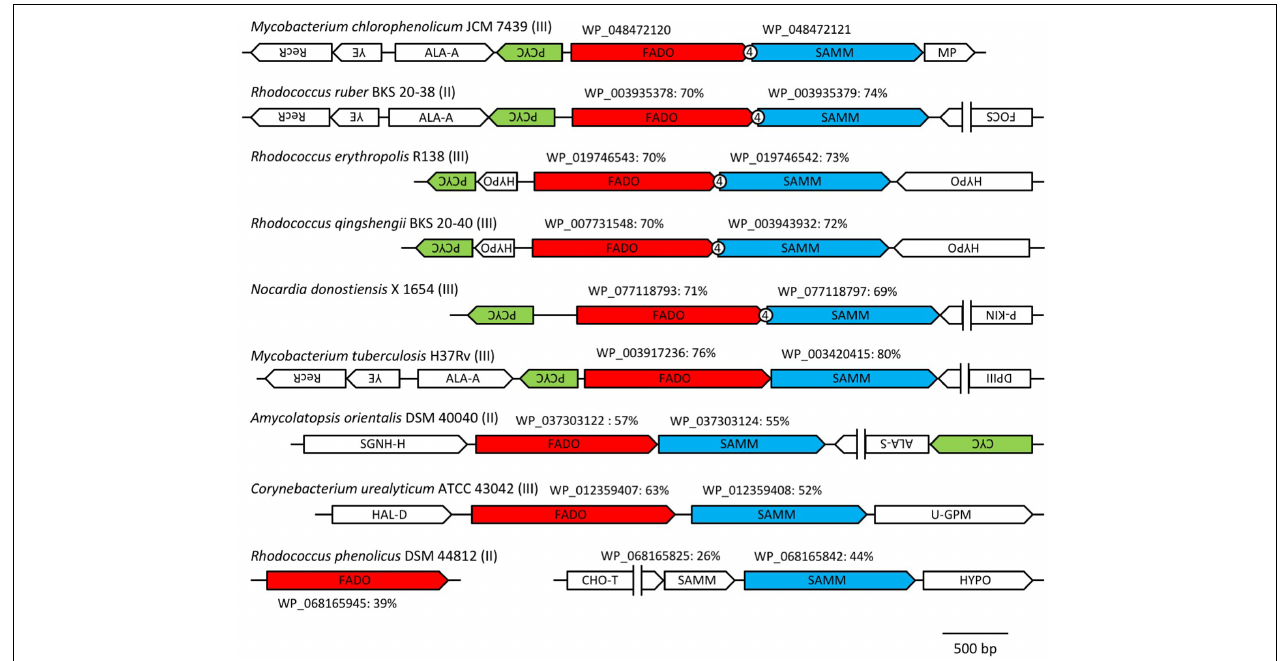
FIGURE 2 | Arrangements of the orthologous genes of the FAD-binding oxidoreductase WP_048472120 and SAM-dependent methyltransferase WP_048472121 among microorganisms that produce medium branched-chain fatty acids (mBFAs). The orthologous genes of the FAD-binding oxidoreductase WP_048472120 and the SAM-dependent methyltransferase WP_048472121 were identified from the genomic sequences of Mycobacterium chlorophenolicum JCM 7439 (NZ_BCQY01000005), Rhodococcus ruber BKS 20-38 (NZ_AOEX01000025), Rhodococcus erythropolis R138 (NZ_CP007255), Rhodococcus qingshengii BKS 20-40 (NZ_AODN01000039), Nocardia donostiensis X 1654 (NZ_MUKP01000048), Mycobacterium tuberculosis H37Rv (NC_018143), Amycolatopsis orientalis DSM 40040 (NZ_ASJB01000001), Corynebacterium urealyticum ATCC 43042 (NC_010545), and Rhodococcus phenolicus DSM 44812 (NZ_LRRH01000116). The genes located near the orthologs of WP_048472121 were drawn schematically. The directions of the arrows indicate the orientation of transcription of the genes. The number “4” in the circle indicates the overlap of four base pairs between the two tandem genes. The group number in Table 1 is shown next to the name of strain. The accession number of each FAD-binding oxidoreductase and SAM-dependent methyltransferase is shown above the arrow indicating each gene. The percentage values indicate the identities of the protein sequences with WP_08472120 or WP_048472121. RecR, recombination protein; YE, YbaB/Ebf family (Jutras et